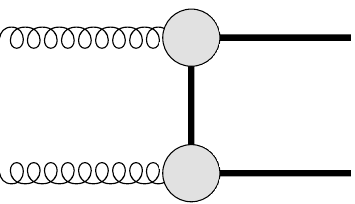
Figure 1 . Class of diagrams leading to enhanced matrix elements at high energy and low scattering